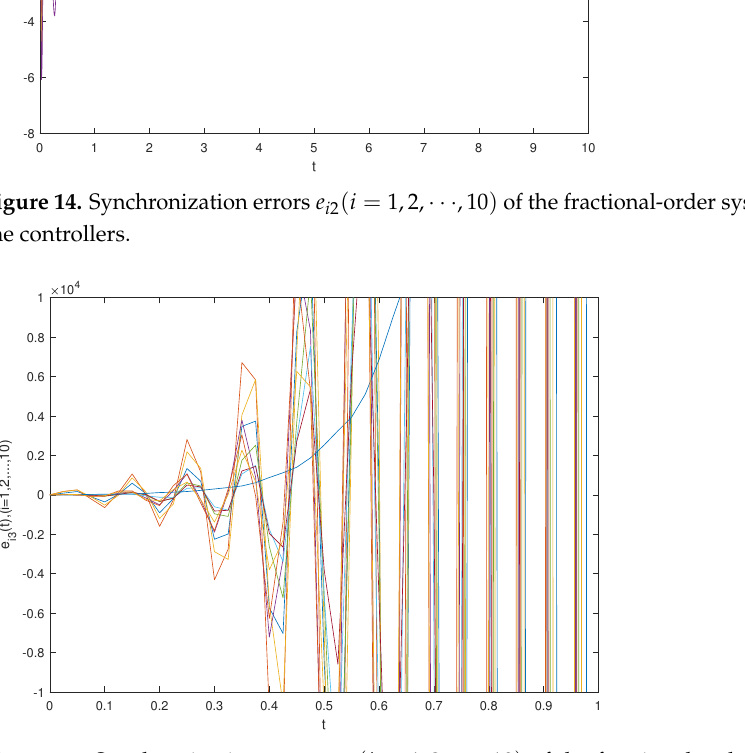
Figure 15. Synchronization errors e i 3 ( i = 1,2, · · · ,10 ) of the fractional-order system (34) and (35) without the